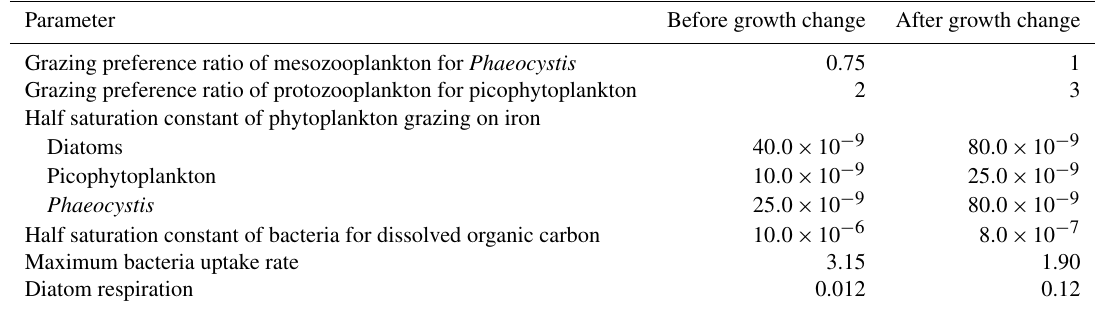
Table A4. Additional tuning parameter values for PlankTOM11 (see Sect. 2.1.5) following the change to the growth rate formulation. “Before growth change” values are those used in PlankTOM10 LQ16 , and “After growth change” values are used in simulations for this study (PlankTOM11, PlankTOM10.5 and PlankTOM10).